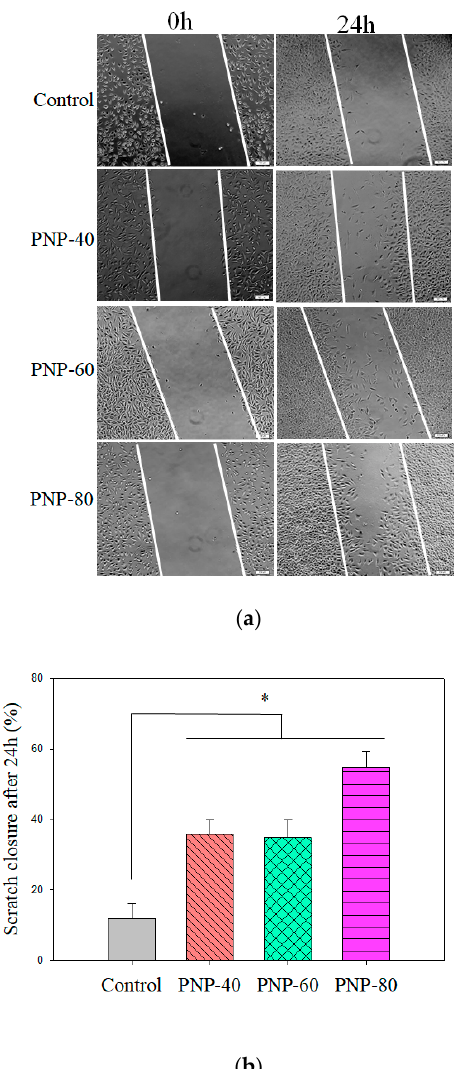
Figure 6. ( a ) L929 fibroblast cells treated PNPs (500 µg/mL) and control group observed after injury to the cell monolayer by using an in vitro scratch assay immediately after scratching (0 h) and 24 h after scratching (scale bar = 100 µm). ( b ) Quantitative analysis of L929 fibroblast cell scratch closure 24 h after the scratch assay. The experiments were conducted in triplicate independently ( n = 3), and the data are expressed as the means ± standard error (SE) (* p < 0.05 compared with control cells; # p < 0.05 compared with PNP-treated cells).